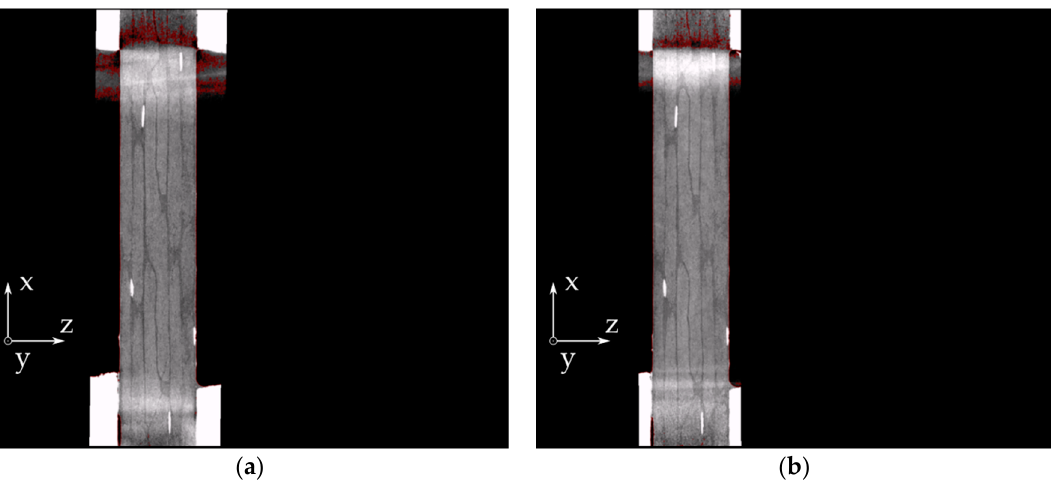
Figure 2. Cross-section visualization of specimen 2 at − 0.5 mm in y-direction: ( a ) point 0, no visible damage; ( b ) point 1, no visible damage.